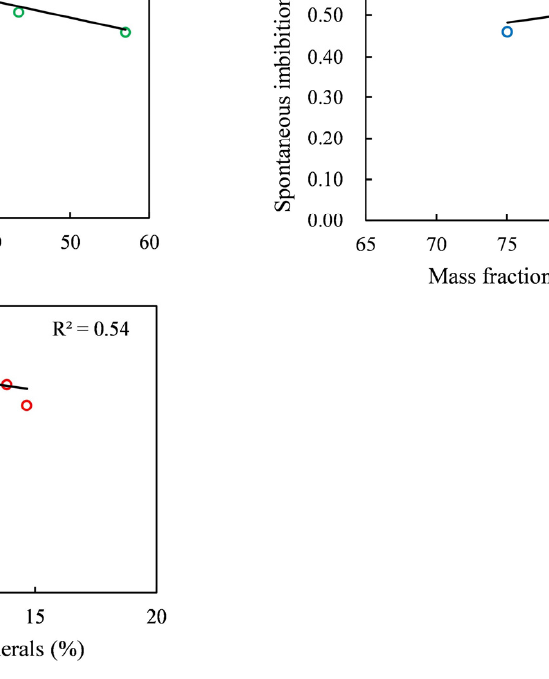
Figure 9. The correlation between different parameters and spontaneous imbibition slope: ( a ) contact angle; ( b ) water-wet minerals; ( c ) oil-wet minerals.